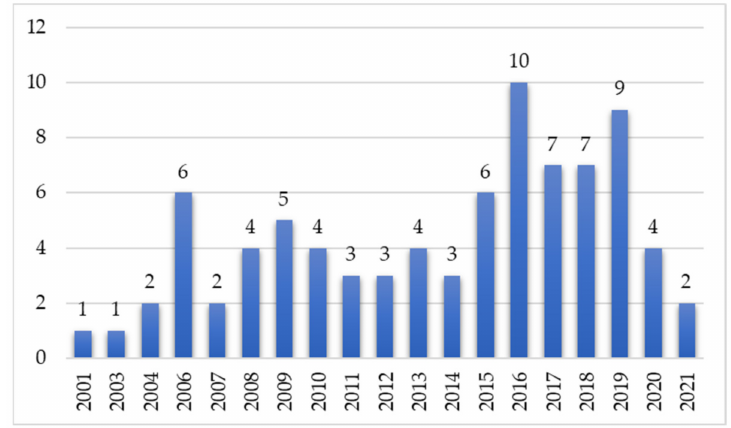
Figure 2. Distribution of papers by publication year.